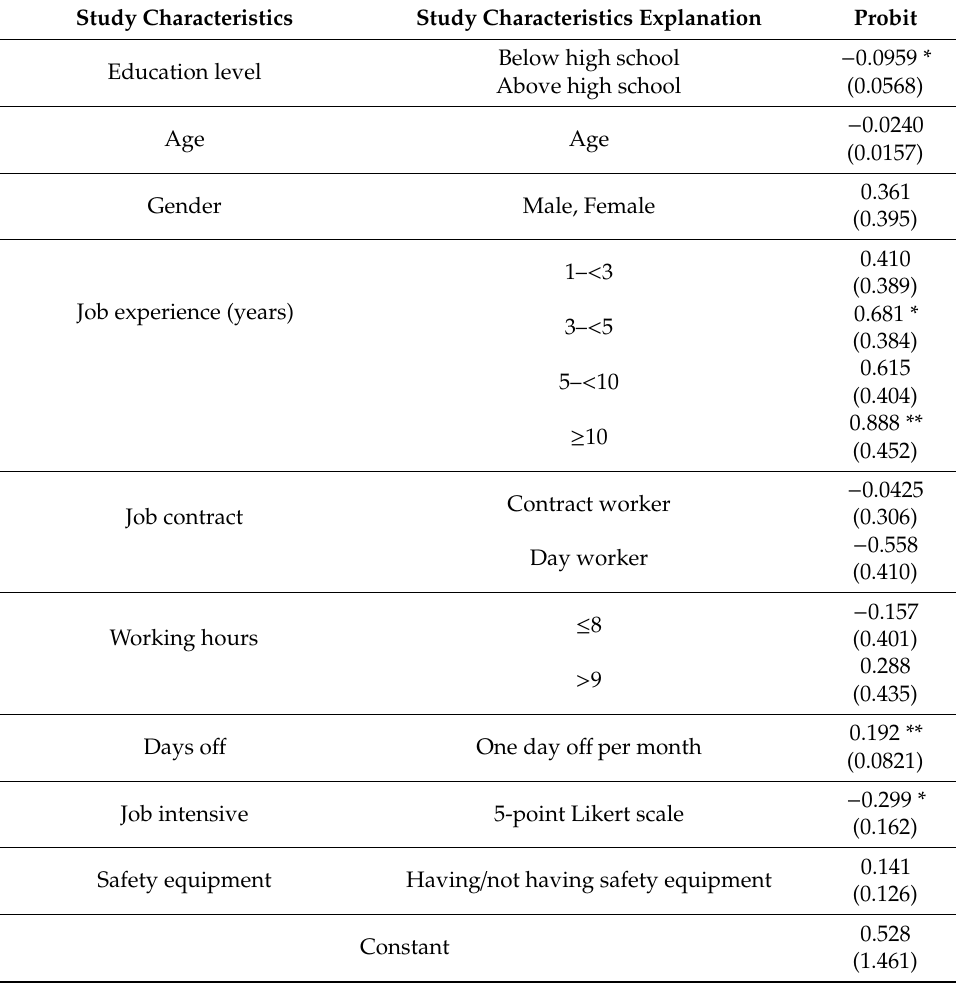
Table 5. Analysis of injury determinants by Probit analysis (N =